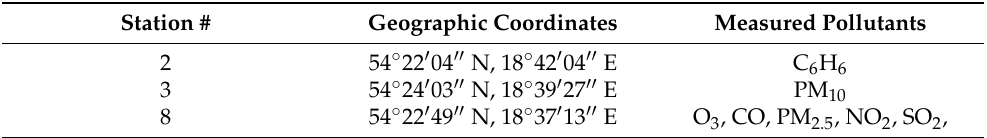
Table 2. Location of monitoring stations and the measured pollutants. Station # Geographic Coordinates Measured Pollutants